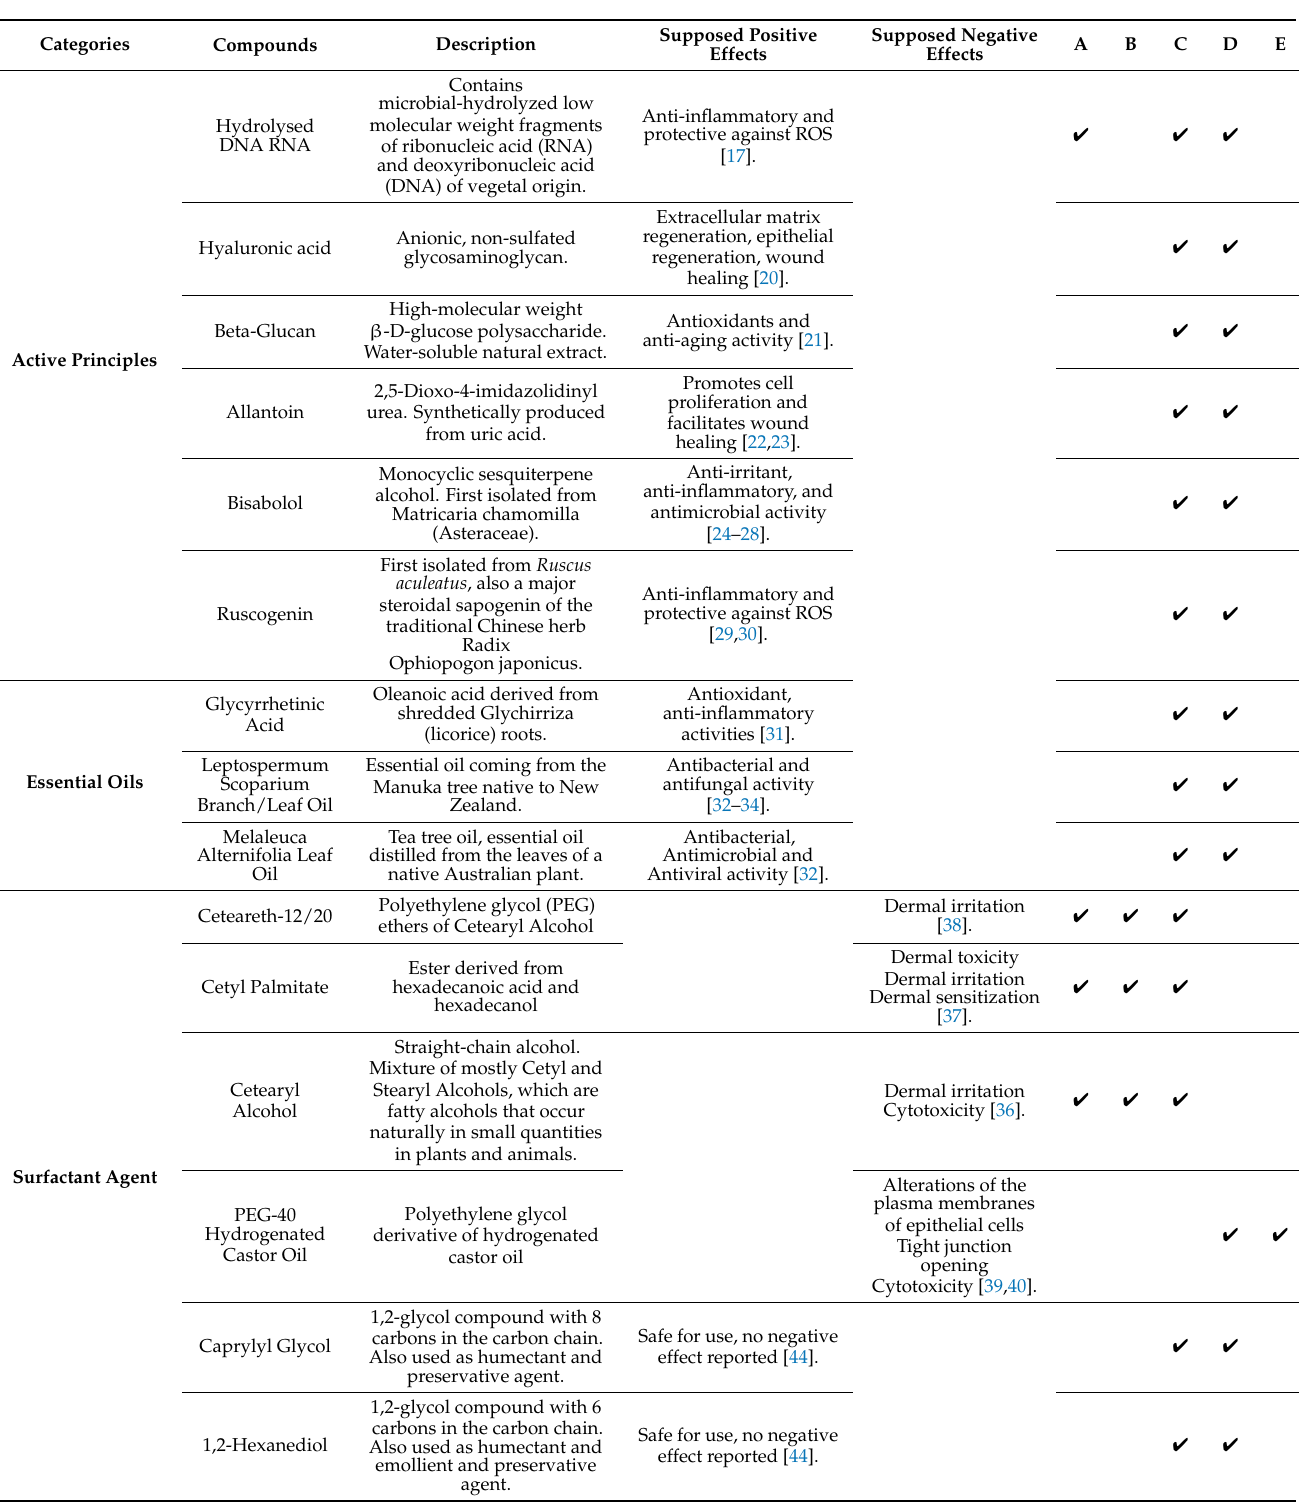
Table 2. Analysis of the compounds used in the tested formulations, together with their documented positive, negative, or neutral